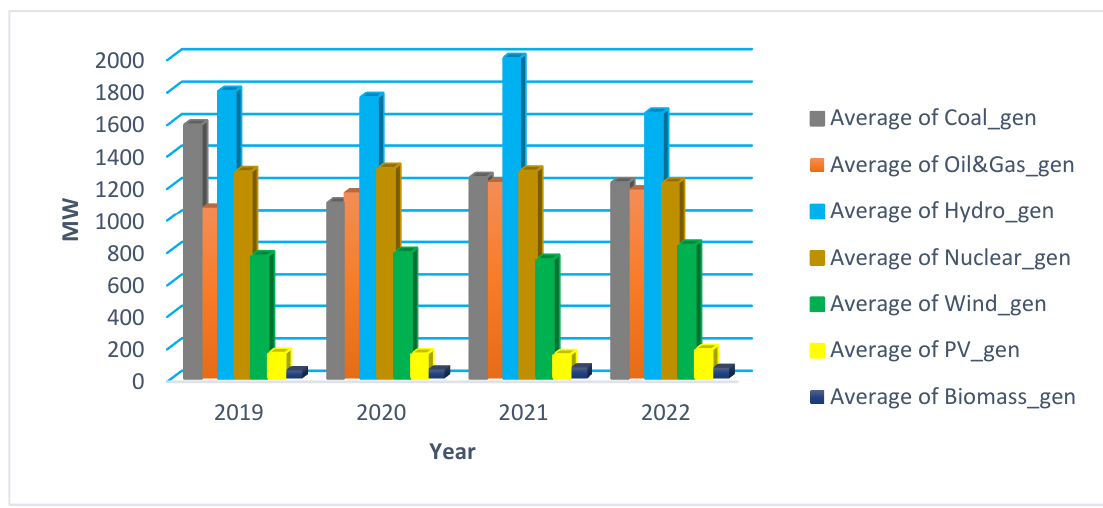
Figure 6. Average contribution to the hourly consumption from 2019 to 2022. The contribution of non-RES is higher than the contribution of RES to the load coverage, but the contribution of non-RES decreased from 3934 MW in 2019 to 3611 MW in 2022 (as in Figure 7). The Pearson correlation coefficients were calculated for each year and are provided in Tables 1–4. Between wind and solar there is an inverse weak correlation (marked in yellow) for the entire interval.